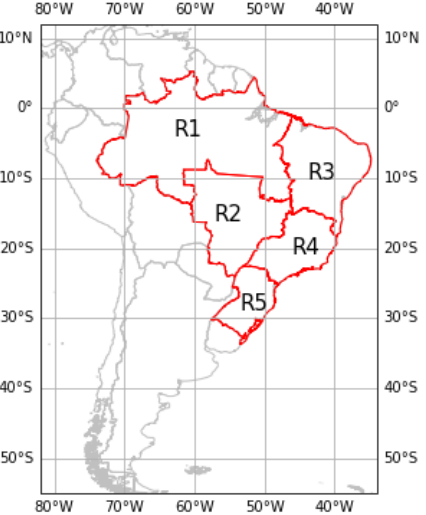
Figure 1. Delimitation of the Brazilian territory and its regions.